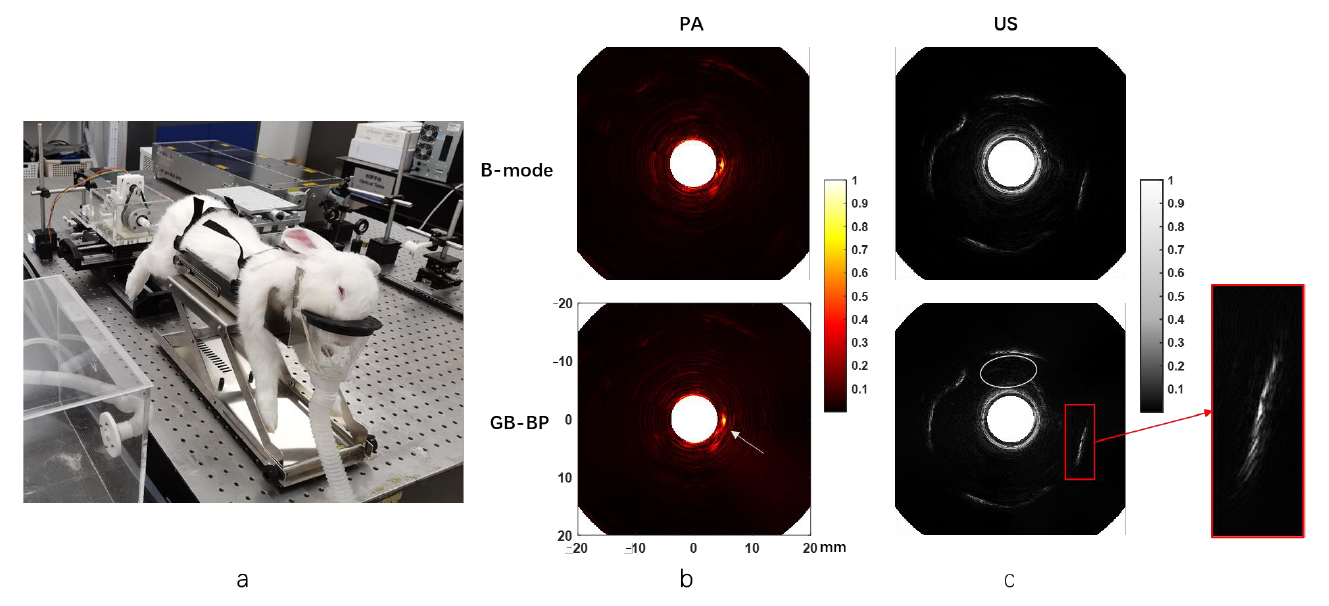
Figure 7. ( a ) The picture of the rabbit rectal endoscopy experiment; ( b ) The rabbit rectal photoacoustic endoscopy images obtained by the B-mode method and GB-BP algorithm; ( c ) The endorectal ultrasonic images of rabbits processed by the B-mode method and GB-BP algorithm. Coordinate axis units are millimeters.